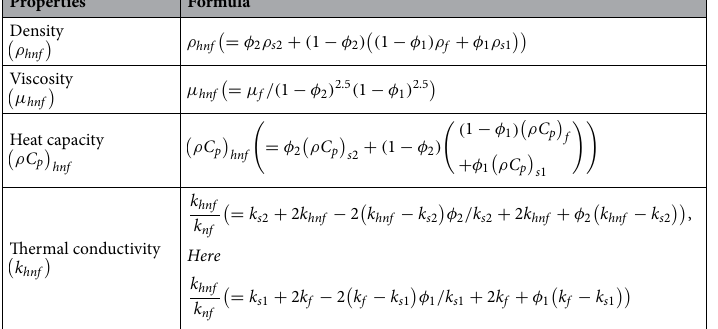
Table 2. Properties of hybrid nanofluid 43 .